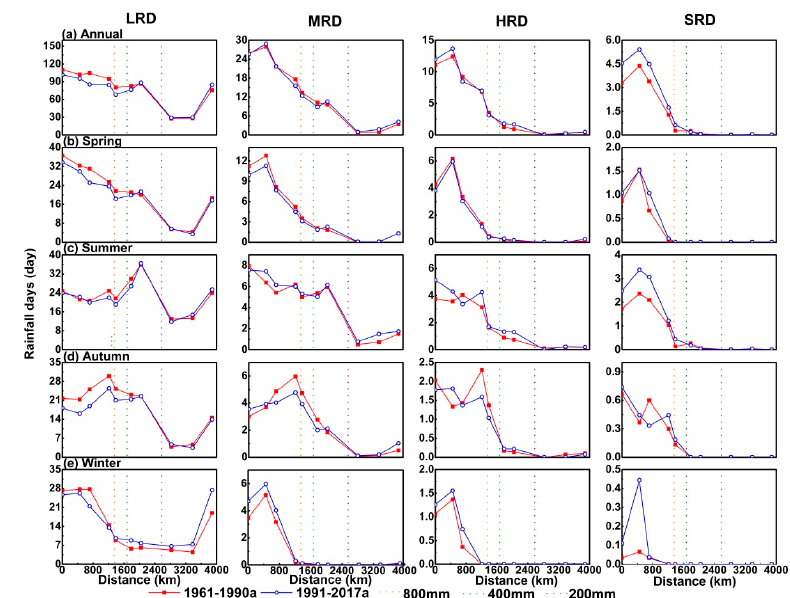
Figure 10. Changes of different grades of precipitation amount with distance from the sea, including light rainfall amount (LRA), moderate rainfall amount (MRA), heavy rainfall amount (HRA), and storm amount (SRA). Different grades of precipitation amount also include annual ( a ) and seasonal (including spring ( b ), summer ( c ), autumn ( d ) and winter ( e )) variations. “800 mm” represents the 800-mm precipitation contour, “400 mm” represents the 400-mm precipitation contour, and “200 mm” represents the 200-mm precipitation contour.